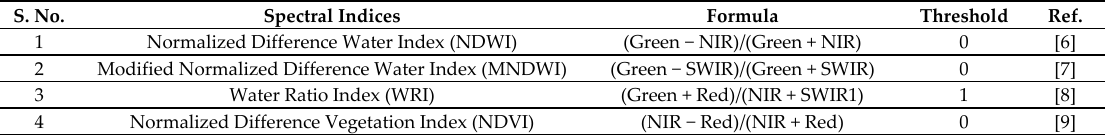
Table 1. Formulae of spectral Indices and their threshold applied in the study area.